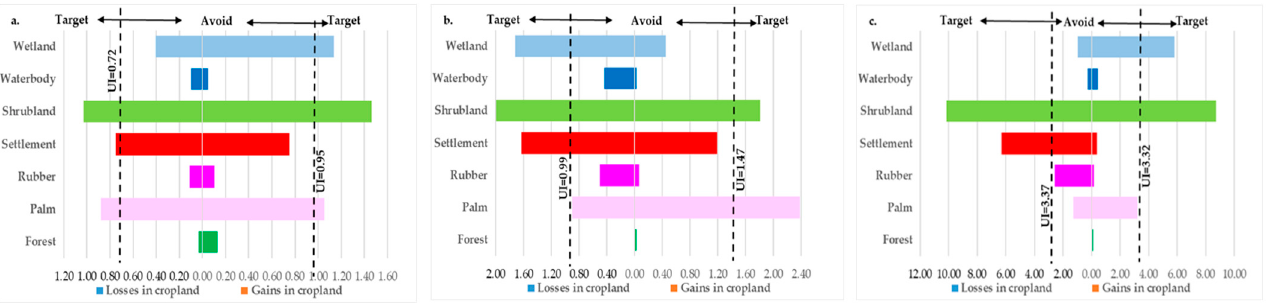
Figure 8. Transition level intensities for settlement for the period ( a ) 1986–2002, ( b ) 2002–2015 and ( c ) 2015–2020 (gains on the right, losses on the left).